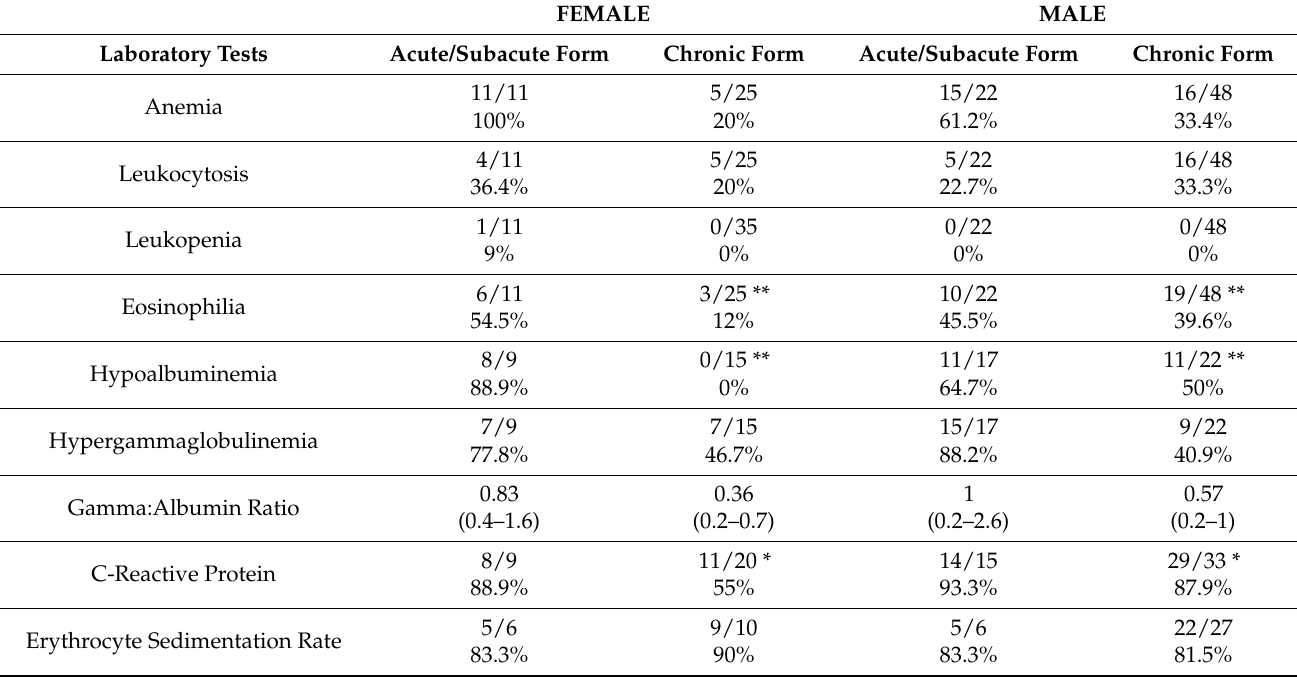
Table 3. Laboratory markers associated with the severity of disease in women and men with paracoccidioidomycosis.